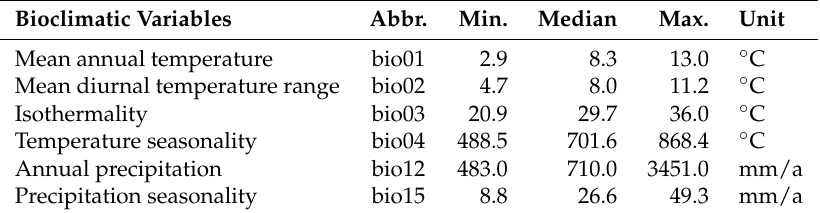
Table 1. Median and range of bioclimatic variables observed at the locations of tick-borne encephalitis virus detections in both ticks and endothermic